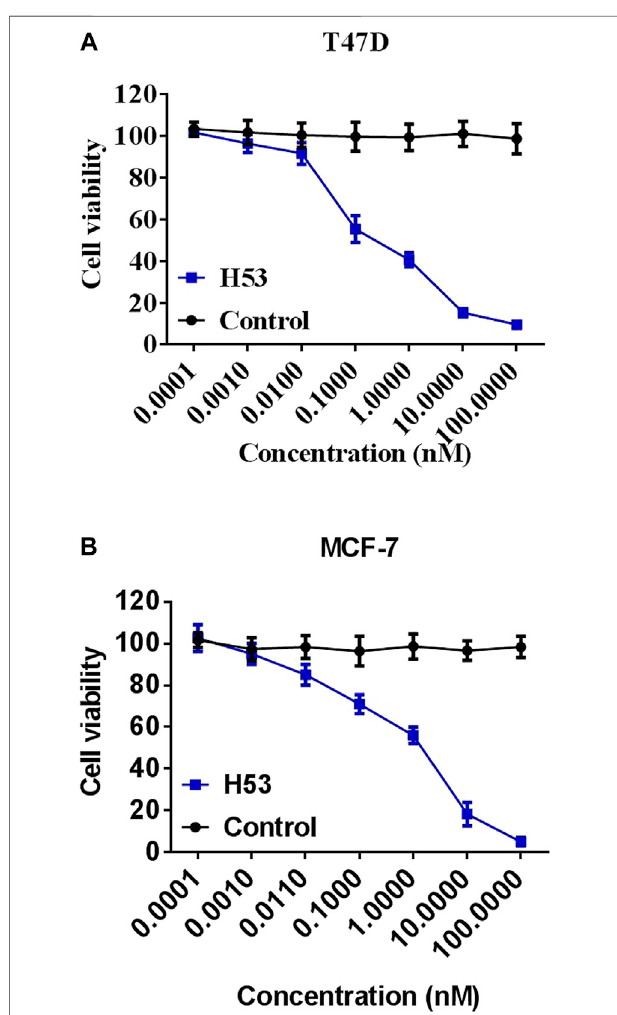
FIGURE 8 | Inhibition of the cell proliferation. MCF-7 (A) and T47D (B) cellsweredispersedina96-wellcultureplate(100ml/well)at acelldensity of1 × 10 4 cells/well. A mixture of constant H53 and an increasing concentrations of H53 or an isotype-matched control antibody were added to the cells on culture plate. The plate was incubated at 37 ° C, 5% CO 2 for 24 h. These cellswereusedtoperformtheCCK-8assay.Theabsorbanceoftheplatewas read using a microplate reader at 450 nm. Date are presented as the mean ± SD of three independent